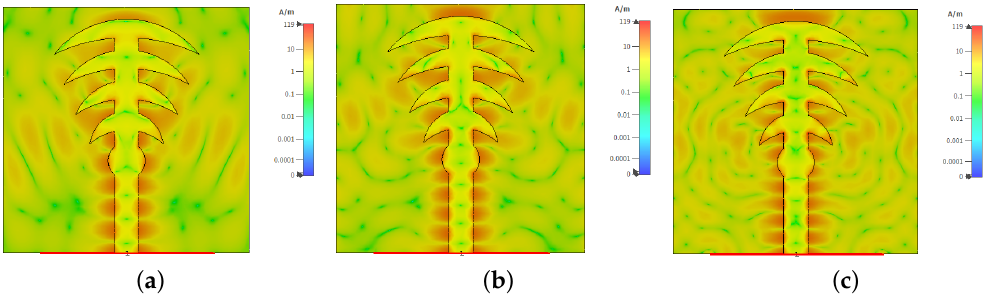
Figure 6. Wideband antenna element current distribution at ( a ) 28 GHz, ( b ) 33 GHz, and ( c ) 38 GHz.